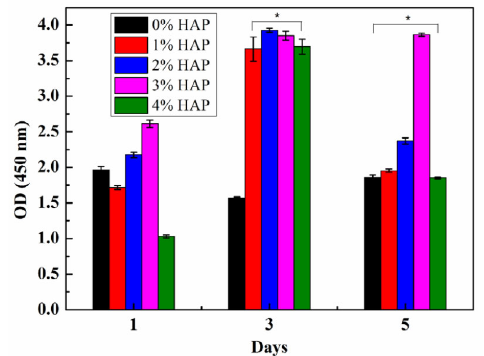
Fig. 4 Viability (absorbance at 450 nm) of rBMSCs on the polished surfaces of PICNs assayed via CCK-8 after culture of 1 day, 3days, and 5 days (* p > 0.05).